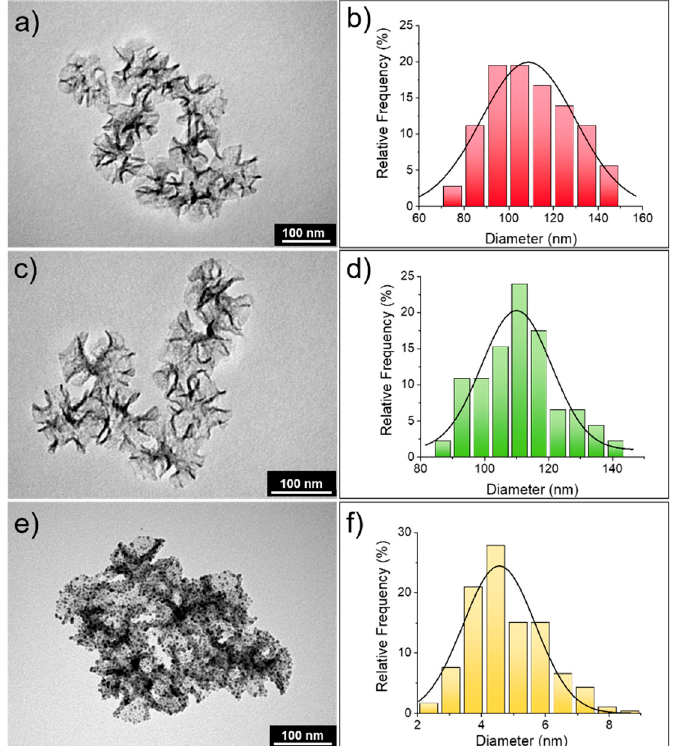
Figure 1. Characterization of star-shaped mesoporous silica nanoparticles (s-MSN), s-MSN-NH 2 , and s-MSN-Au. TEM images ( a , c , e ) and size distribution obtained from the analysis of TEM images ( b , d , f ) of s-MSN, s-MSN-NH 2 , and s-MSN-Au samples, respectively (the size distribution in panel f is related to the Au nanostructures adsorbed on silica surface).